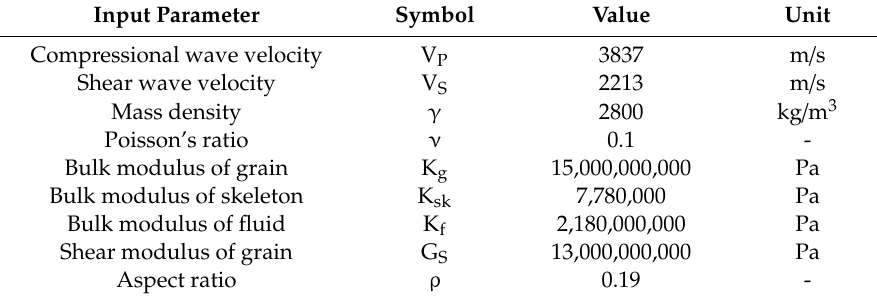
Table 1. True value for sensitivity analysis obtained by Byun et al.